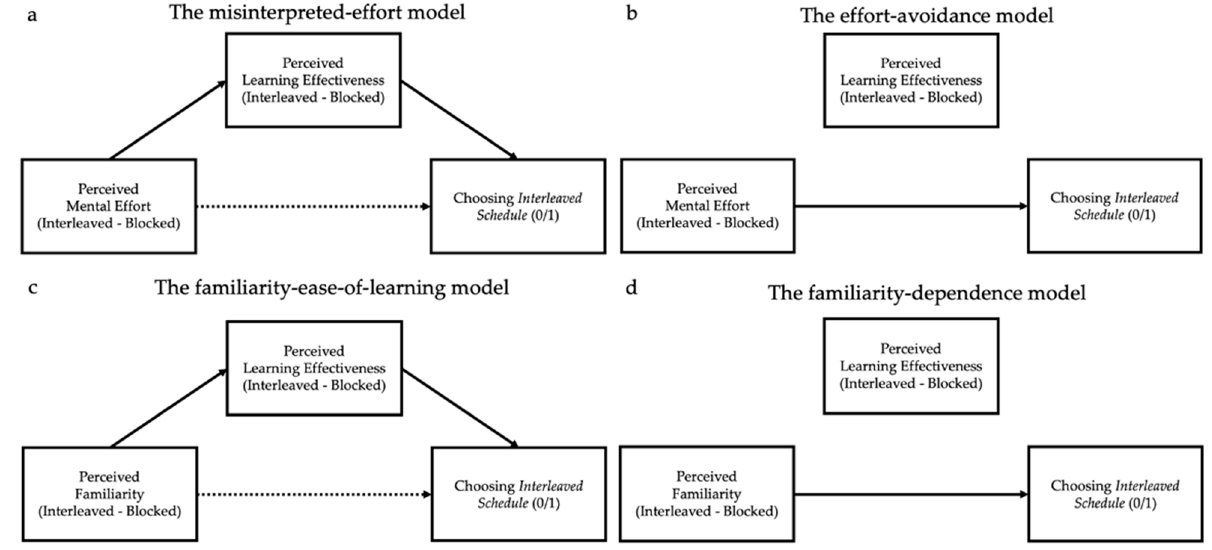
Figure 1. ( a ) Theoretical model of a mediation analysis, focusing on the role of perceived mental effort on perceived learning effectiveness on strategy choice ( b ) or a direct link between perceived mental effort to strategy choice, independent of perceived learning; ( c ) theoretical model of a mediation analysis focusing on the role of perceived familiarity on perceived learning effectiveness on strategy choice ( d ) or a direct link between perceived familiarity to strategy choice, independent of perceived learning.